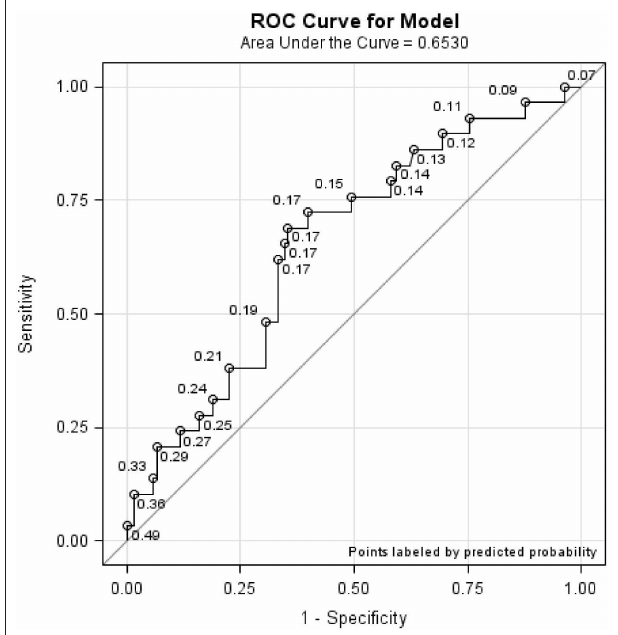
FIGURE 4 | ROC curve demonstrating predictive validity of the three-level Quick-STEADI algorithm for fall risk, adjusted for age, sex, and education.